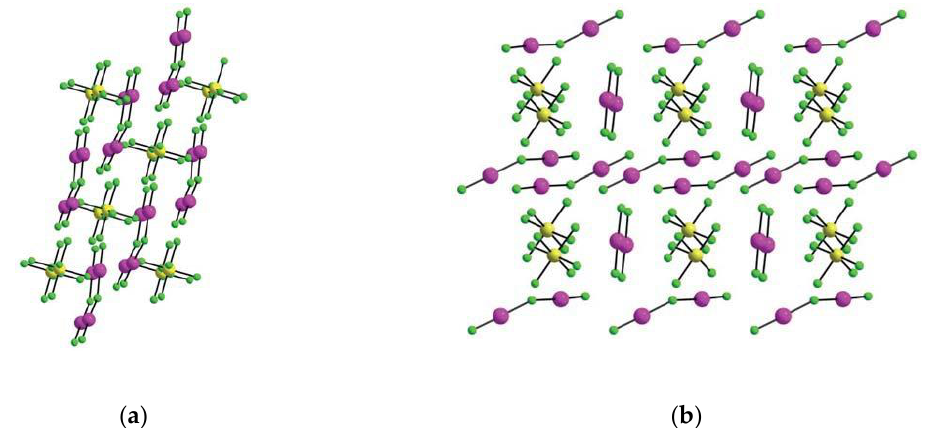
Figure 1. ( a ) Packing diagram of [Xe 2 F 3 ][RuF 6 ] along b -axis.; ( b ) Packing diagram of [Xe 2 F 3 ][RuF 6 ] · XeF 2 .